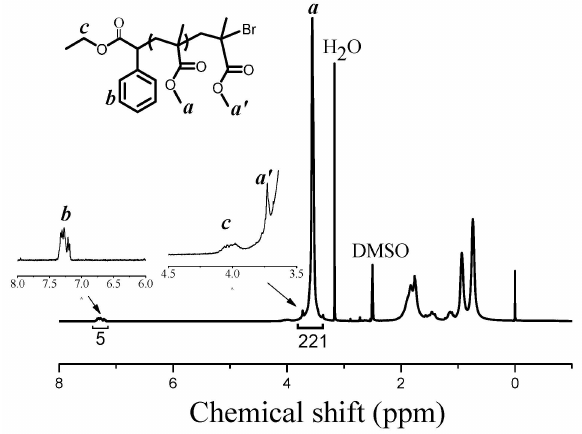
Figure 3. 1 H NMR spectrum of the resultant PMMA with DMSO-d 6 as solvent and tetramethylsilane (TMS) as internal standard. Polymerization conditions of sample PMMA ( M n,GPC = 6570 g/mol, M w / M n = 1.16): [MMA] 0 :[EBPA] 0 :[Fe(acac) 3 ] 0 :[PPh 3 ] 0 :[ACHN] 0 = 200:2:0.03:0.3:1, V MMA = 2.0 mL,